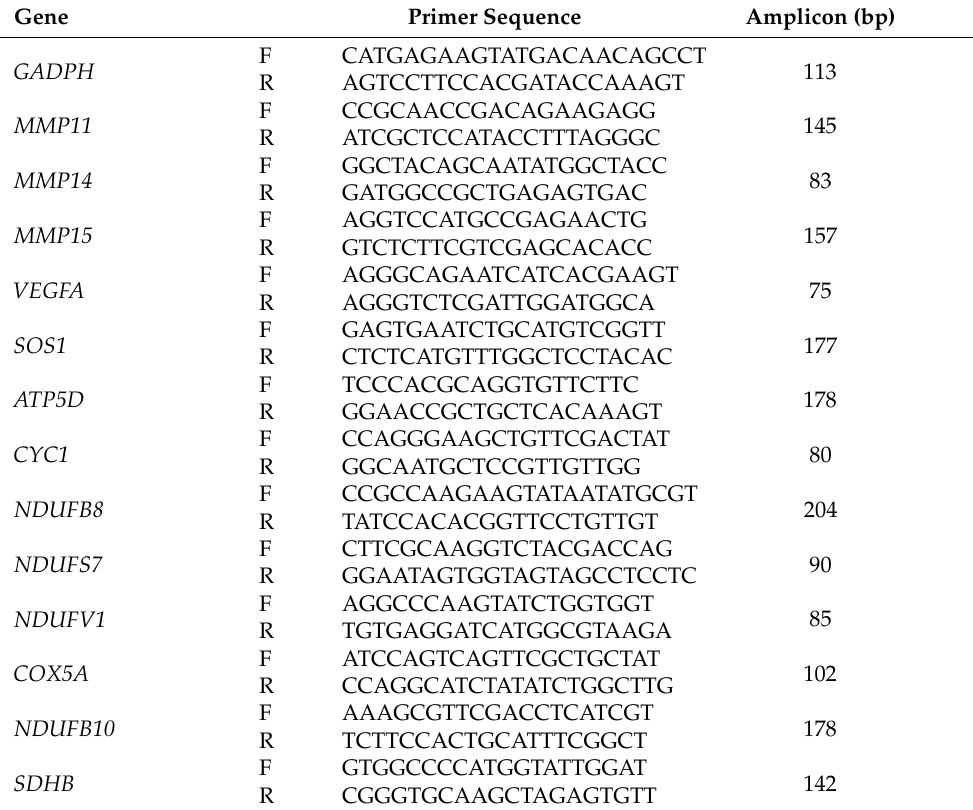
Table 2. The primer pairs used in real-time